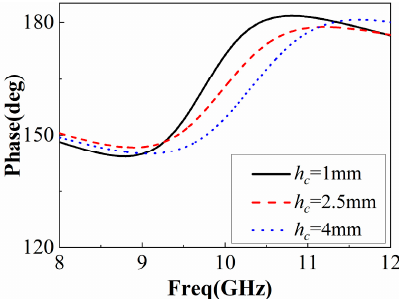
Figure 7. Variation of PRS reflection phase with h c .